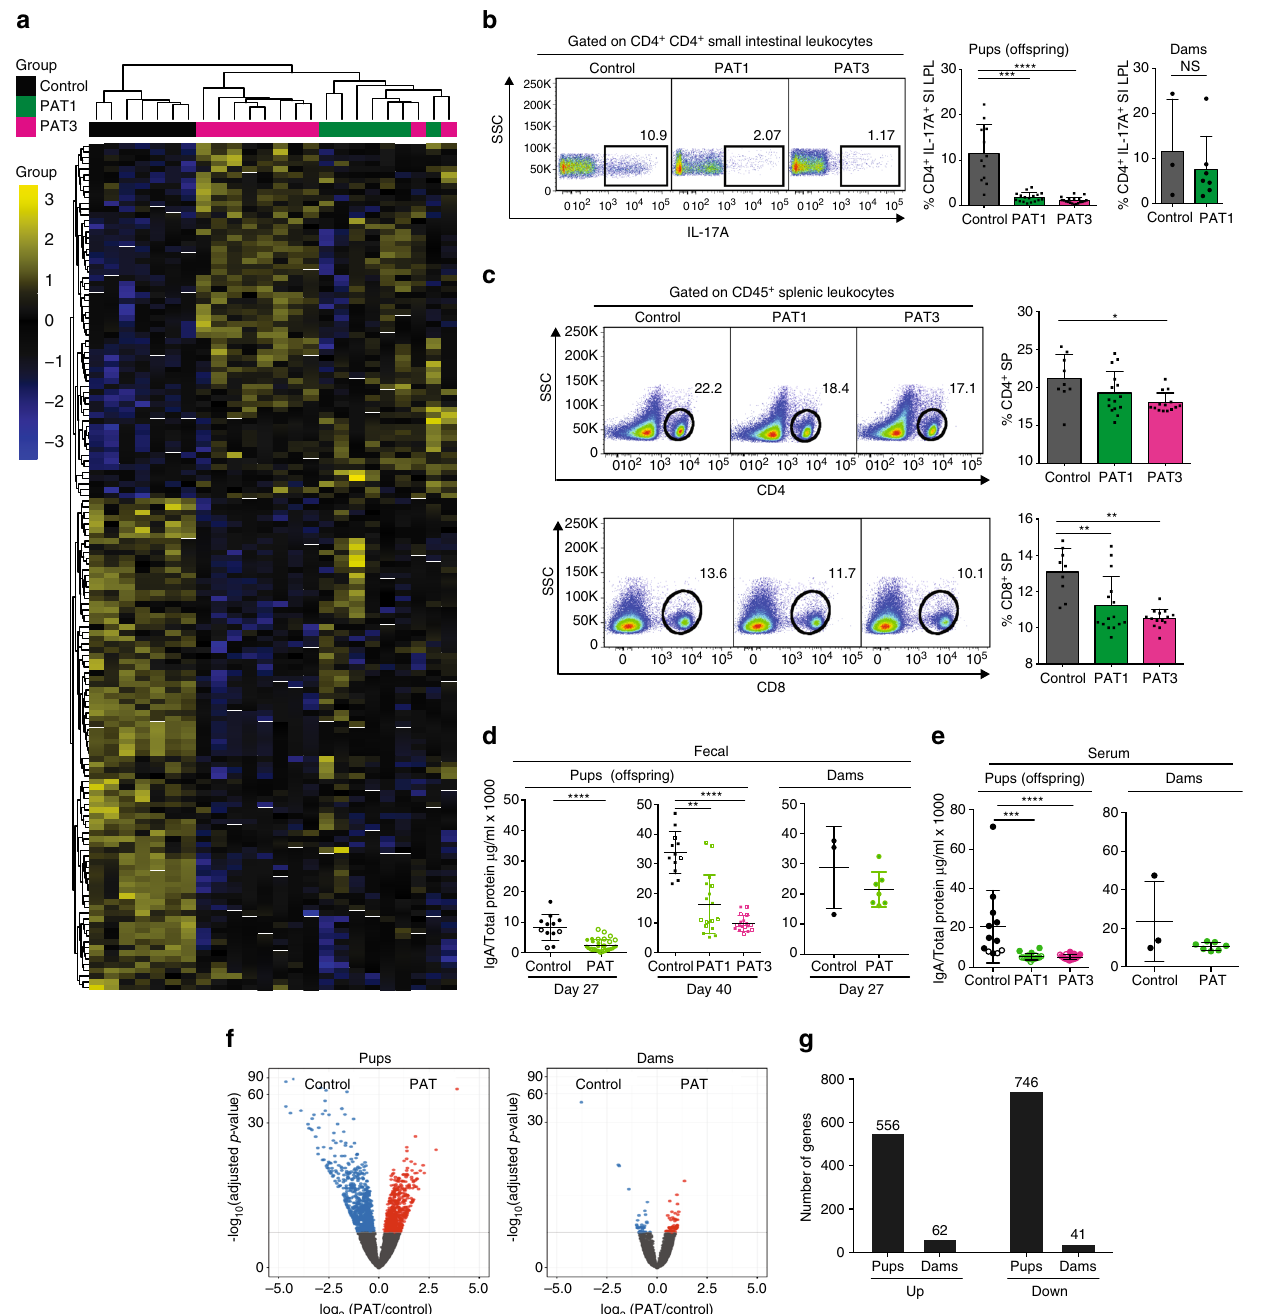
Fig. 2 Administration of one or three macrolide courses alters ileal gene signatures and T-cell populations. a Heatmap with unsupervised clustering of FDR- corrected, differential ileal gene expression pro fi les using Nanostring technology (Control ( n = 7), PAT1 ( n = 8) and PAT3 ( n = 9)). After one-way ANOVA, Tukey HSD multiple comparison testing and FDR-correction, 148 genes remained signi fi cantly different between the groups. b Mean ( ± SD) frequency of small intestine lamina propria lymphocytes after PAT1, PAT3 or control exposure. Cells were isolated at sacri fi ce from pups (mean P52) and their respective dams (P61). Populations were gated on live CD45 + CD4 + cells, and representative frequencies of CD4 + IL17A + cells shown. c Frequency of splenic lymphocytes after PAT1, PAT3 or control exposure. Cells were isolated from pups at sacri fi ce, gated on CD4 + and CD8 + populations, and representative frequencies shown. Data compiled from three experiments ( n = 9 – 19 mice/group). d Secretory IgA ( μ g/ml) (mean ± SD) in fecal samples of control and PAT-exposed dams at P27 and their pups at P27 and P40. e Serum IgA ( μ g/ml) (mean ± SD) in control and PAT-exposed mice in pup and dam samples at mean P52 or P61, respectively. For panels ( b – e ) signi fi cance testing performed using the Mann – Whitney non-parametric test or the Kruskal – Wallis non-parametric test used with Dunnett ’ s multiple comparisons test. f Volcano plots showing signi fi cant global ileal transcriptomic alterations in pups and dams, determined by RNAseq; n > 16,000 genes examined, control ( n = 3) and PAT ( n = 6) dams, respectively; control ( n = 3) or PAT ( n = 4) pups. g Differentially expressed genes in relation to PAT exposure in P52 pups, and their dams at P61, determined by RNAseq, and depicted by direction of differences. For all panels: * p < 0.05, ** p < 0.01, *** p < 0.001, **** p <